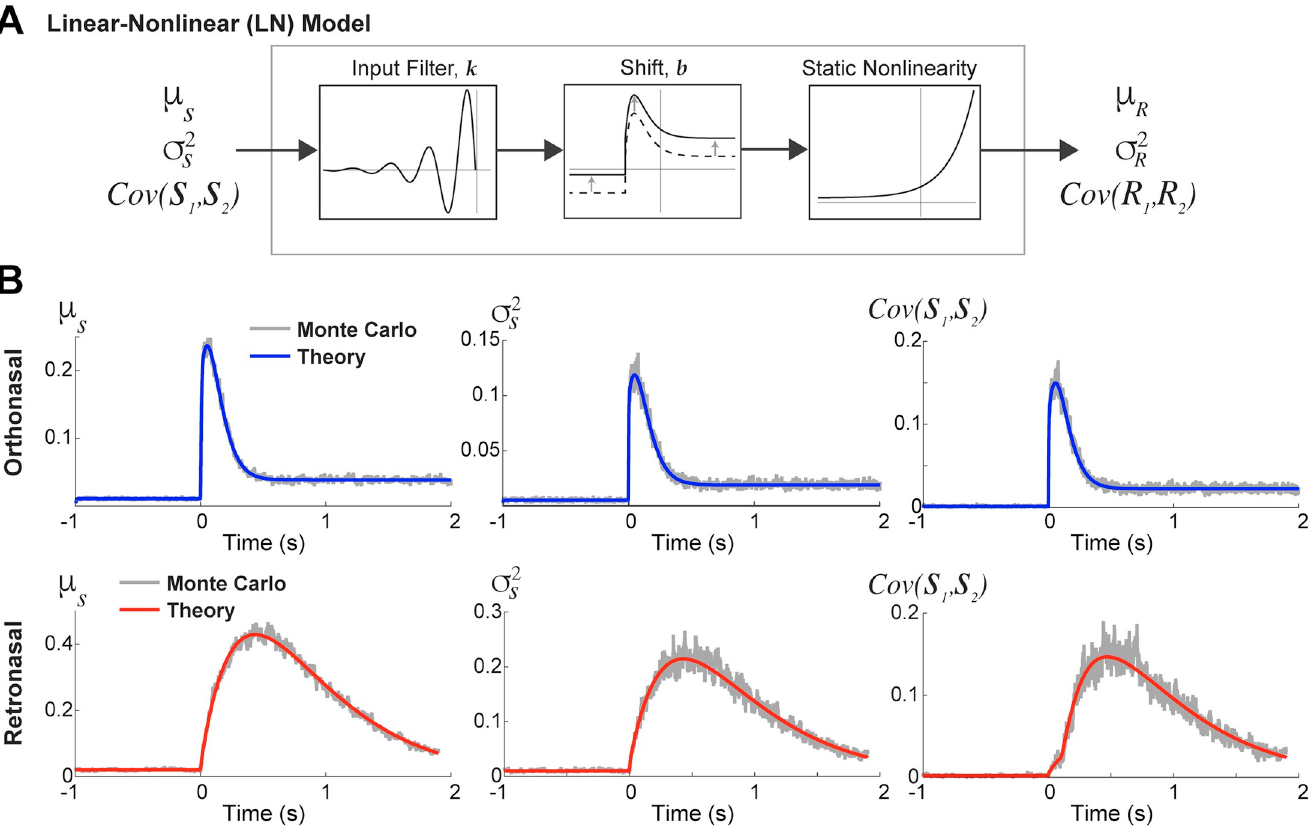
Fig 4. LN framework used to analyze OB transfer of input statistics. A ) Schematic of the phenomenological linear-nonlinear (LN) model to approximate how the OB network transfers input statistics. B) The actual ortho (top row) and retro (bottom row) input synapses used in the biophysical OB model results in Fig 3. Comparisons of the Monte Carlo simulations (Eqs (11) and (12)) and theoretical calculations (Eqs (13), (18) and (22) for respective columns) show smooth curve matches even for correlated time-varying (inhomogeneous) Poisson processes.